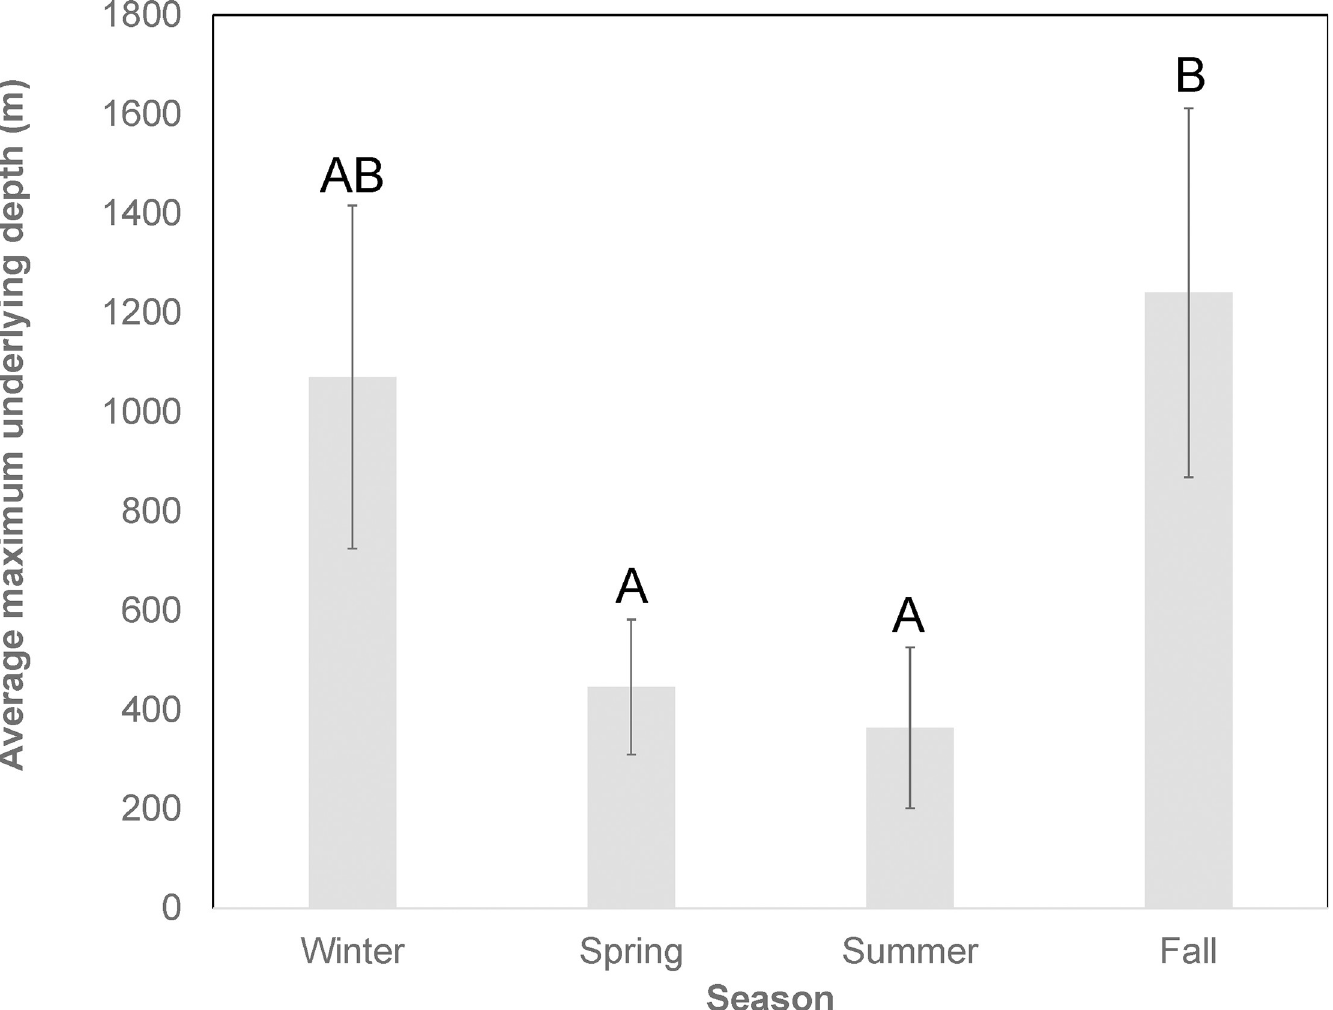
Fig 6. Vertical bar chart of average maximum underlying bottom depths by season. Mean values are individual averages. Error bars represent standard errors of the mean and letters designate statistically significant groups as revealed by Tukey’s pairwise comparisons. Seasons that share at least one letter are not significantly different from one another (i.e,. P > 0.05), whereas those that do not share a letter are statistically distinct (i.e., P <